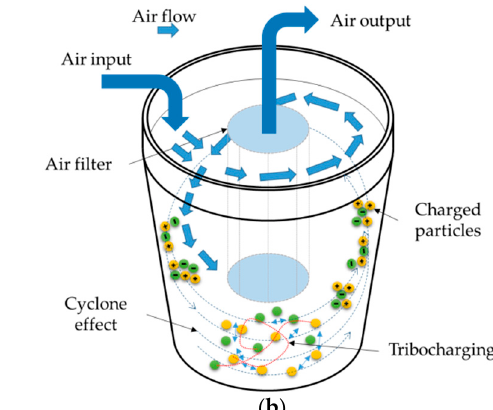
Figure 6. The view of tribocharging containers made of: ( a ) PET-G, ( b ) PLA/ABS, ( c ) ASA, ( d ) PP, ( e ) assembled container, air filter and airflow in suction head.